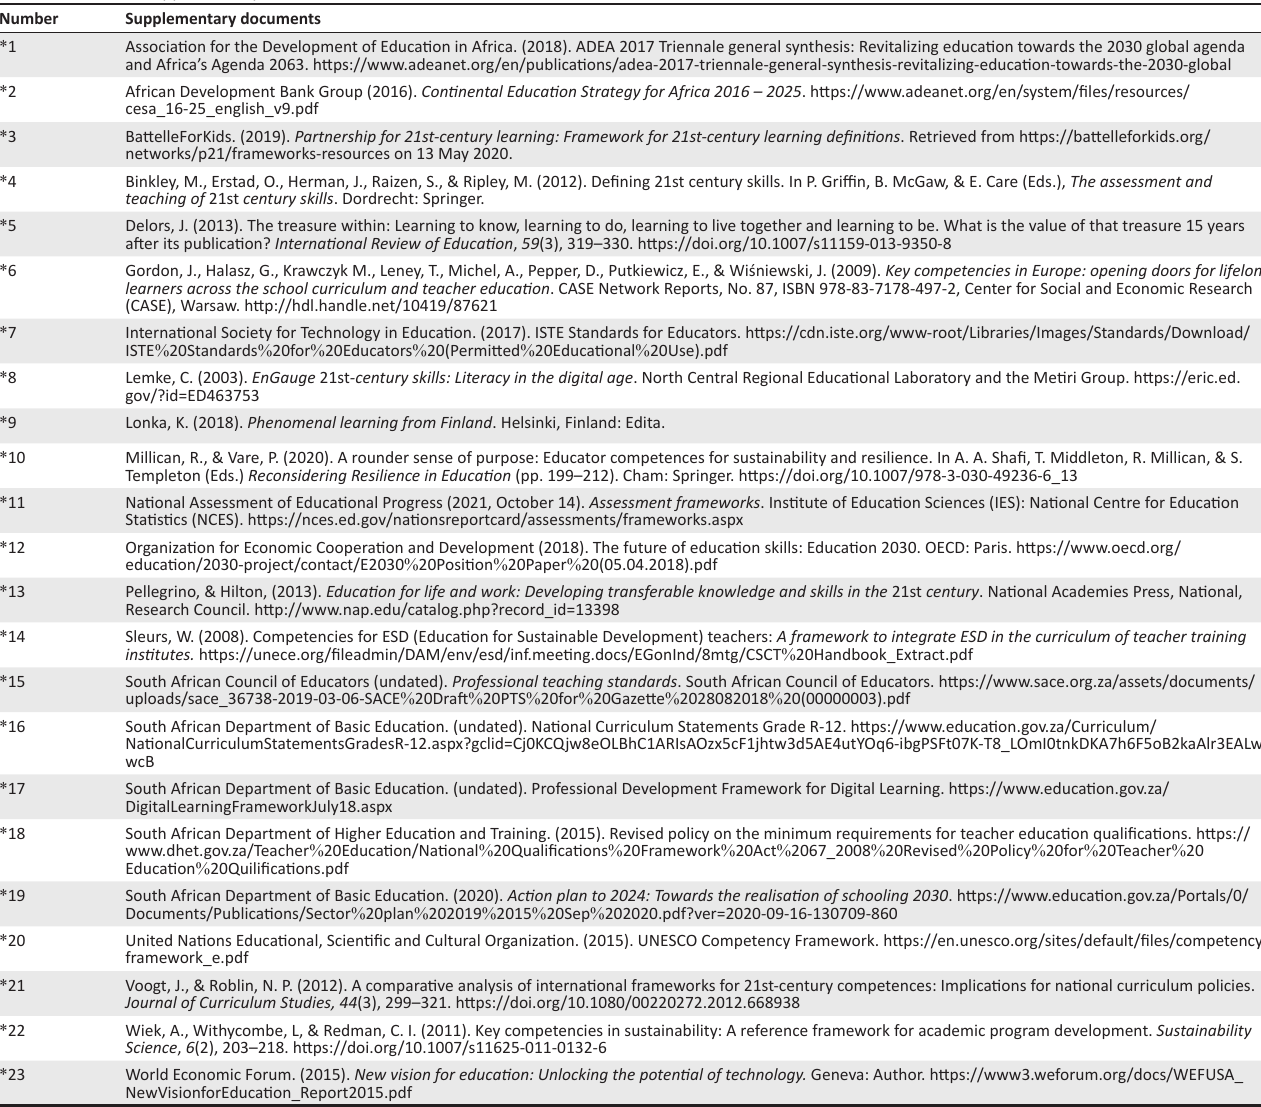
TABLE 1-A1: List of supplementary documents mentioned in Table